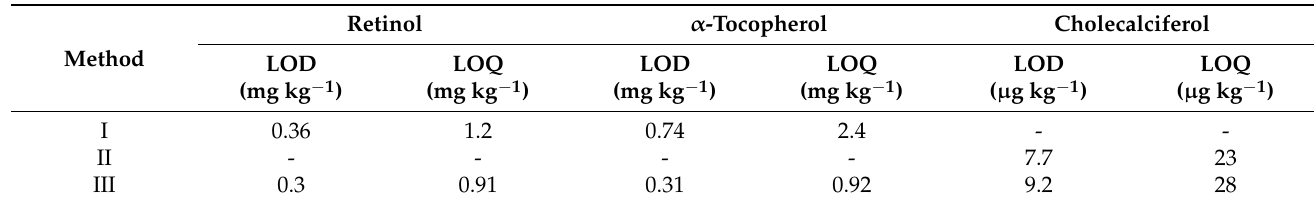
Table 8. Methods - limit of detection (LOD) and limit of quantitation (LOQ) of each vitamin.